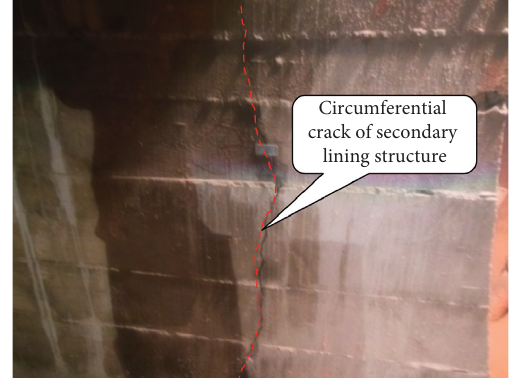
Figure 15: Circumferential crack of secondary lining structure.